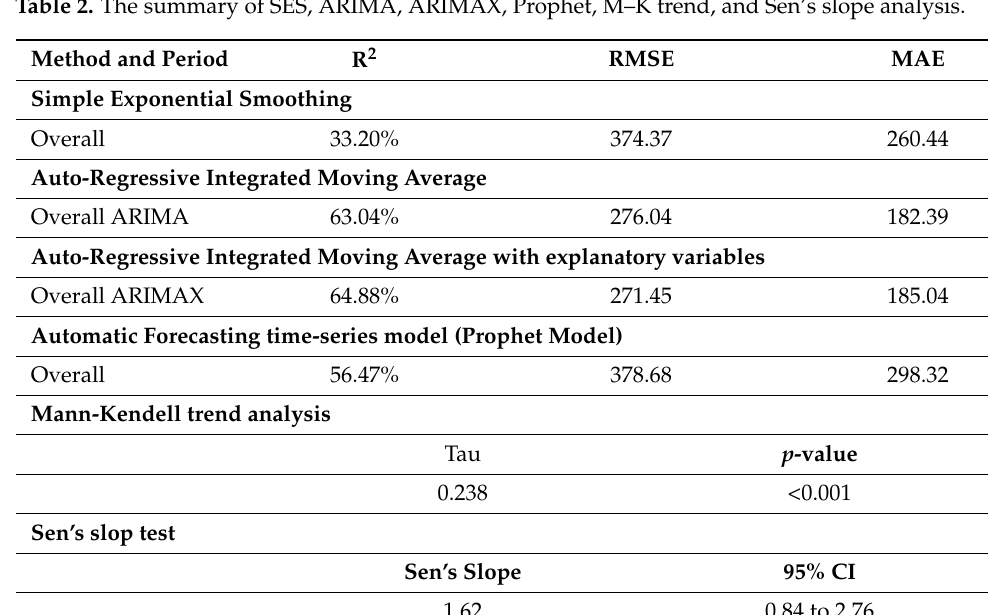
Figure 3. The global distribution of the total (cumulative) monkeypox cases in different countries and continents (10 November 2022). Table 2. The summary of SES, ARIMA, ARIMAX, Prophet, M–K trend, and Sen’s slope